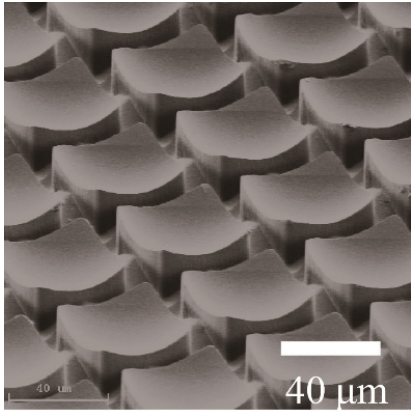
Figure 6. Bird’s-eye SIM images of the sample molded without evacuation.